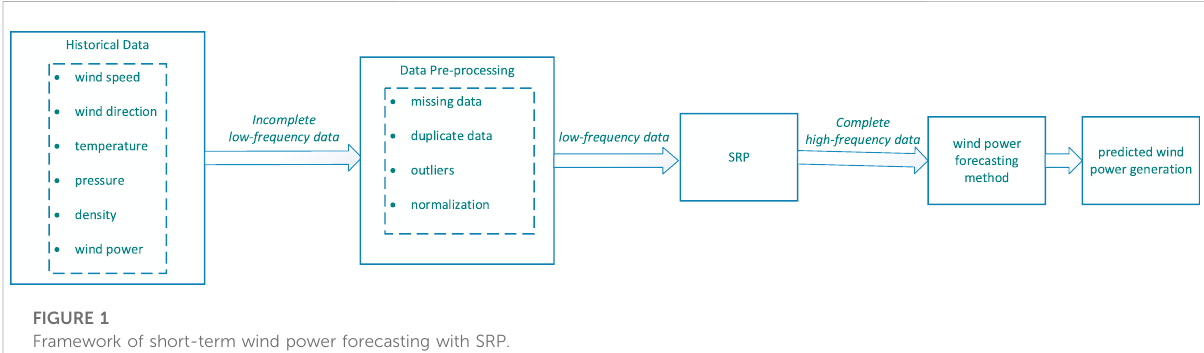
FIGURE 1 Framework of short-term wind power forecasting with